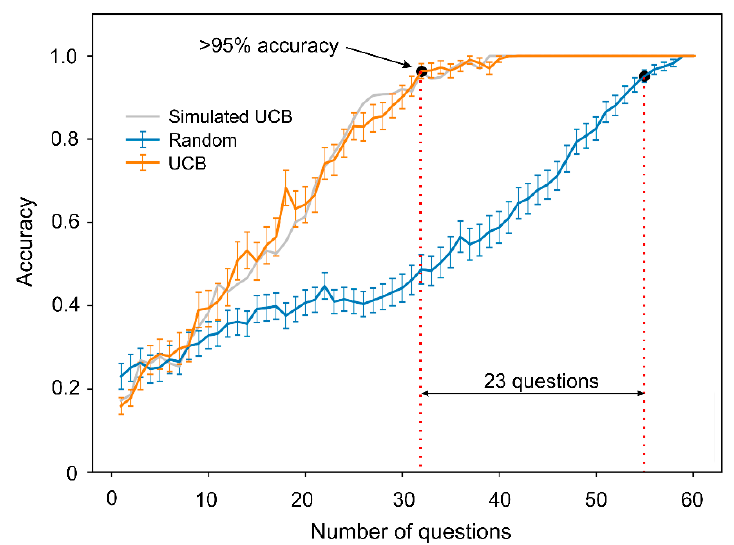
Figure 3. Average accuracy of formative assessment for 104 students. Simulated Upper-Confidence Bound (UCB) line is for 104 synthetic students to show that synthetic experiments are congruent with reality. The error bars represent SEM.